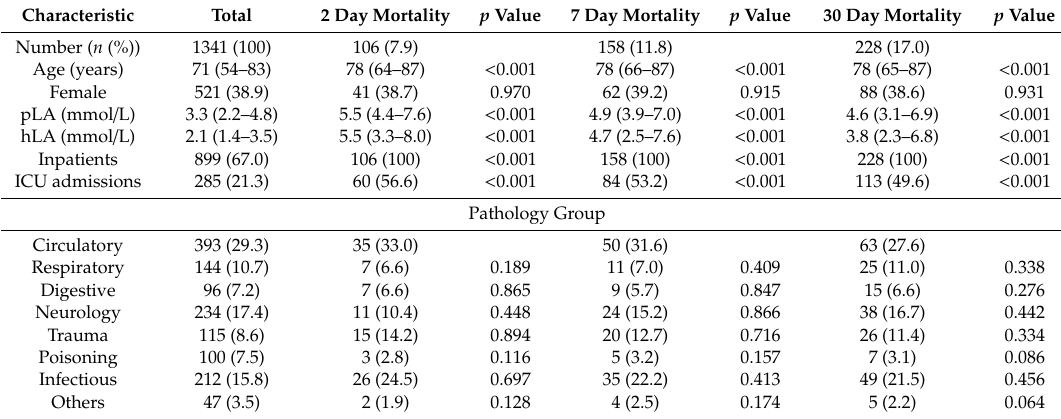
Table 1. Demographic, prehospital and hospital clinical outcomes.